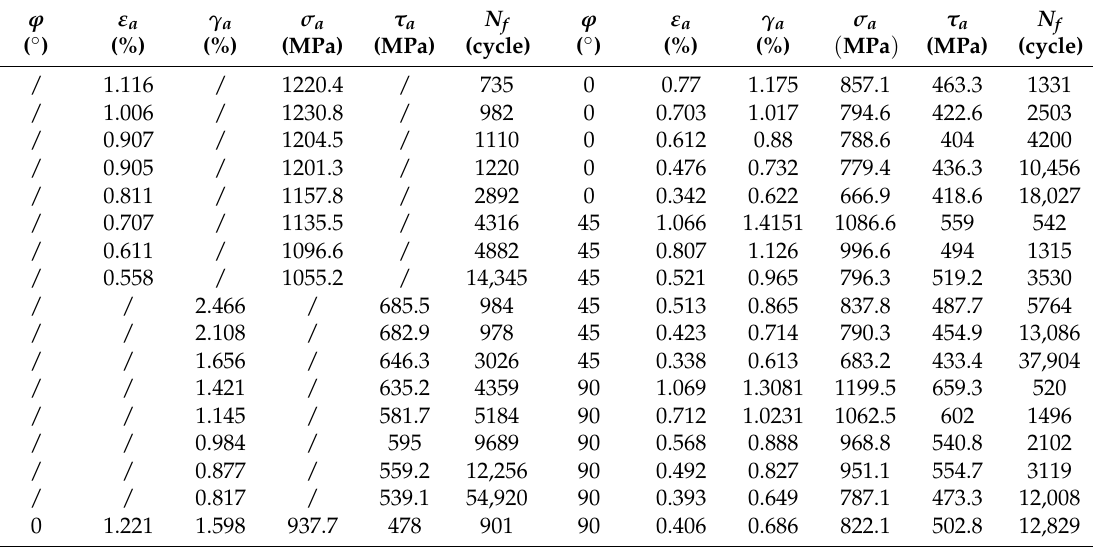
Table 2. The experimental data for GH4169 under symmetric loadings.